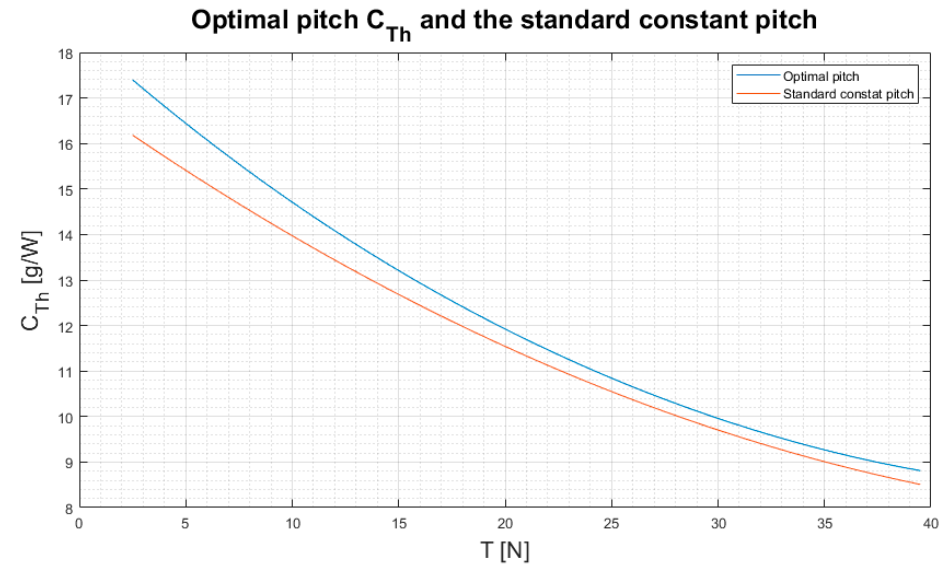
Figure 12. Comparison of C Th for optimal pitch and standard constant pitch.